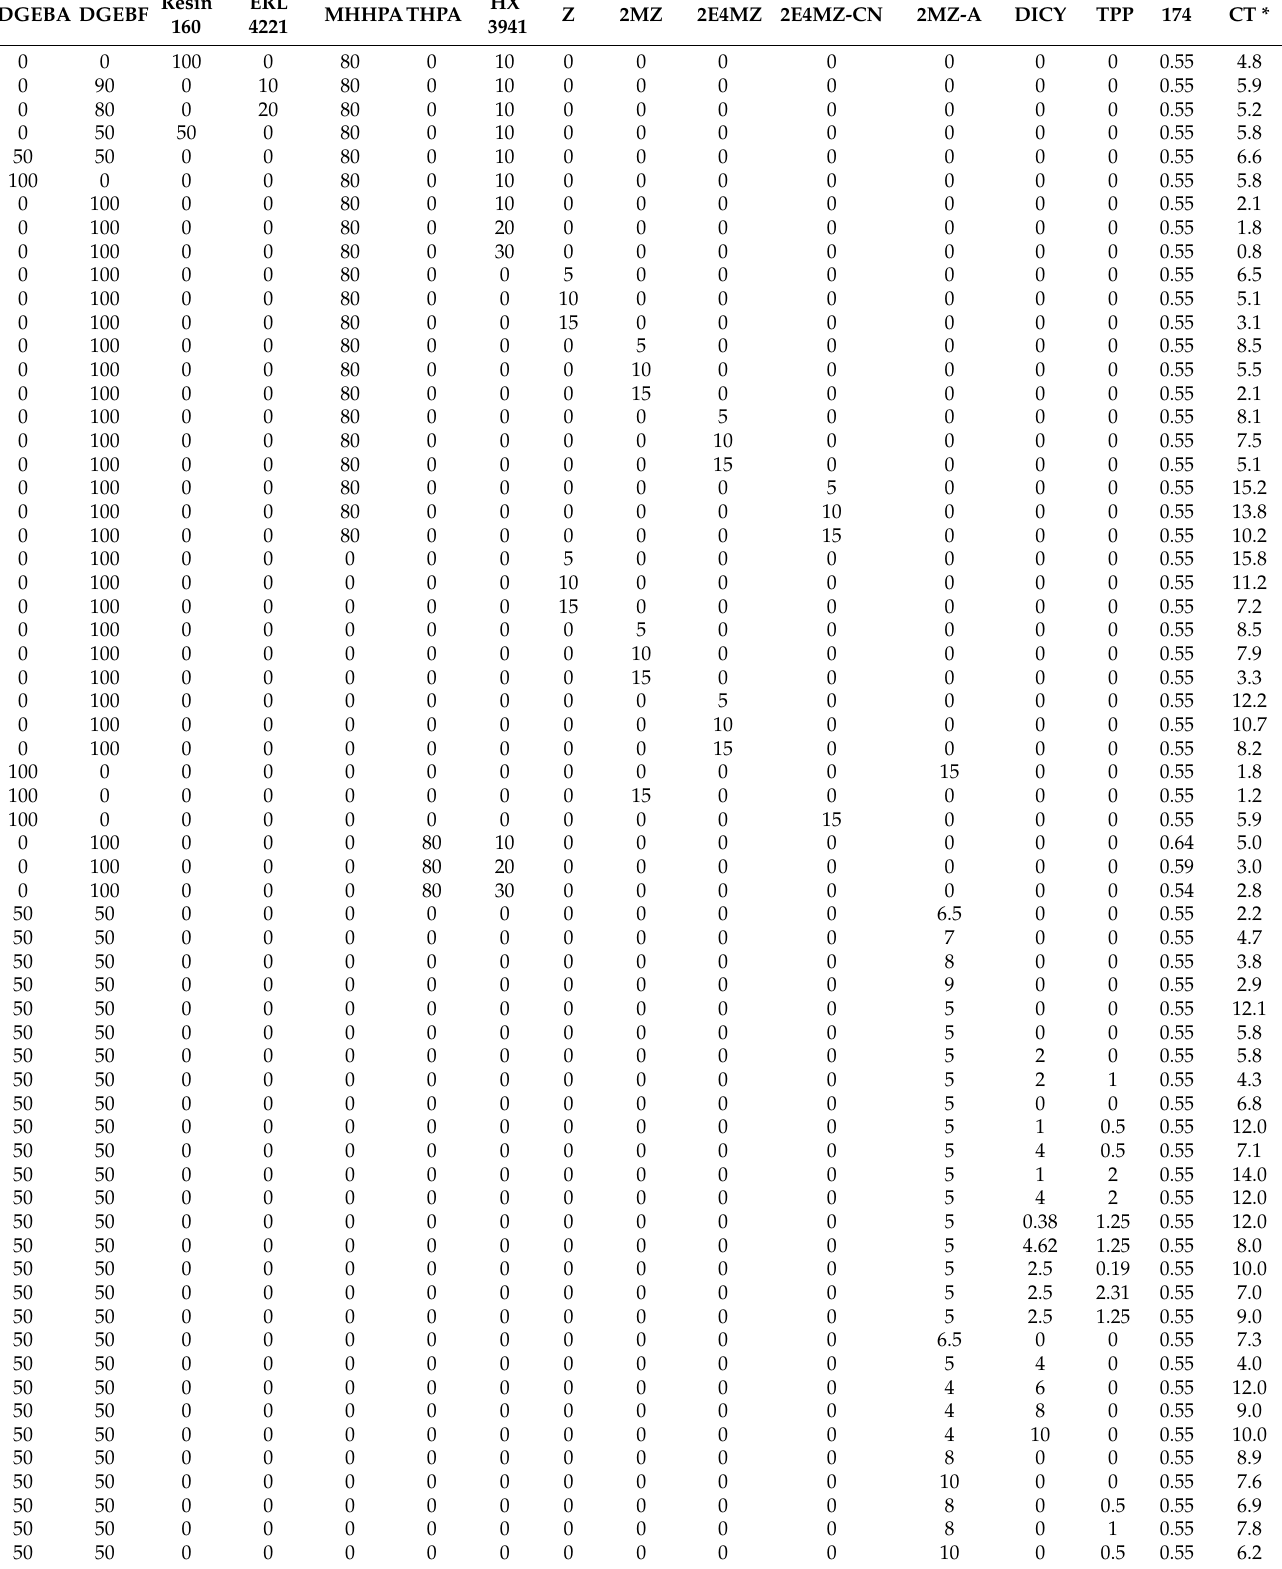
Table A1. Data set for curing time of